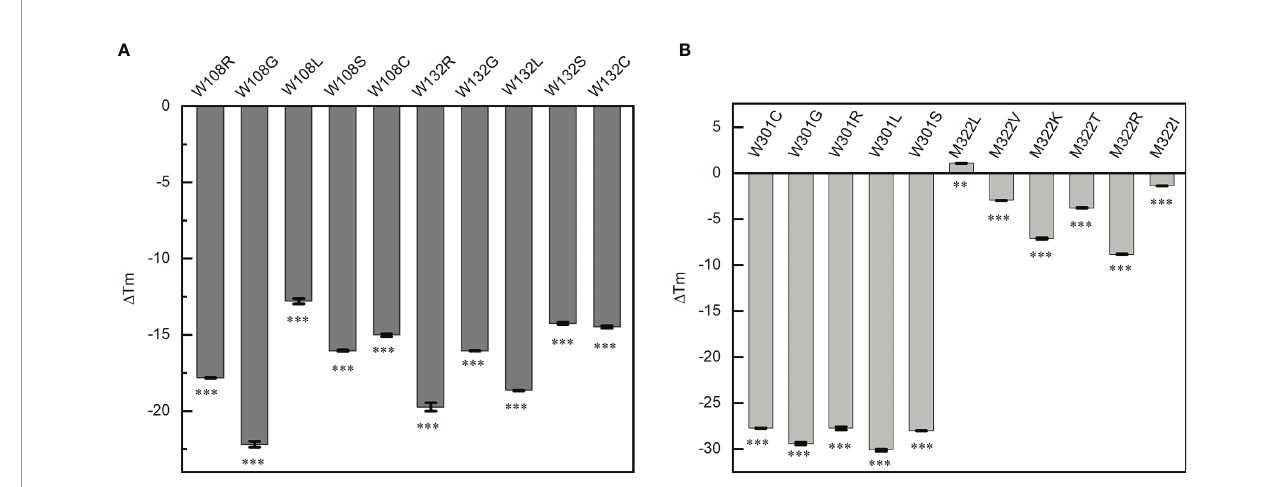
FIGURE 4 | Point mutations affect the thermal stability of the corresponding domains. (A) Thermal transition midpoint temperature difference of the mutant domains at positions W108 and W132. (B) Thermal transition midpoint temperature difference of the mutant domains at positions W301 and M322. Student ’ s t -test was used to conduct statistical analysis, and differences were considered signi fi cant when p < 0.05, ** p < 0.01, and *** p <